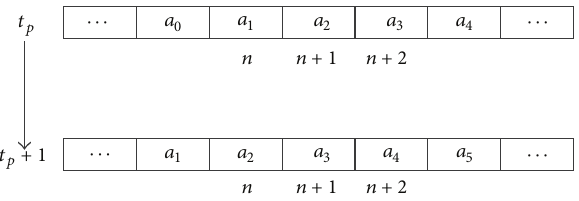
Figure 6: One-dimensional cellular movement rules of queues.